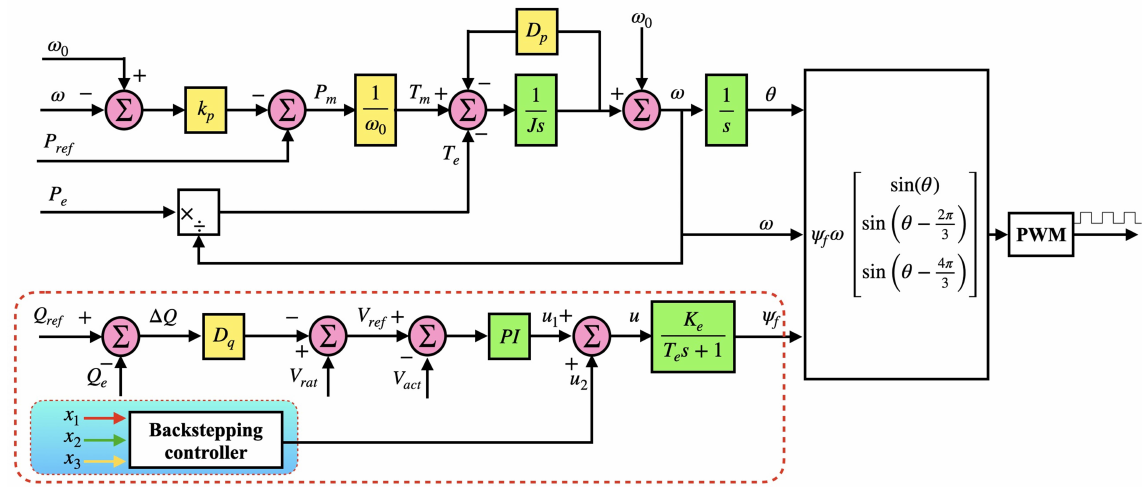
Figure 3. Structure of VSG control circuit with compensating